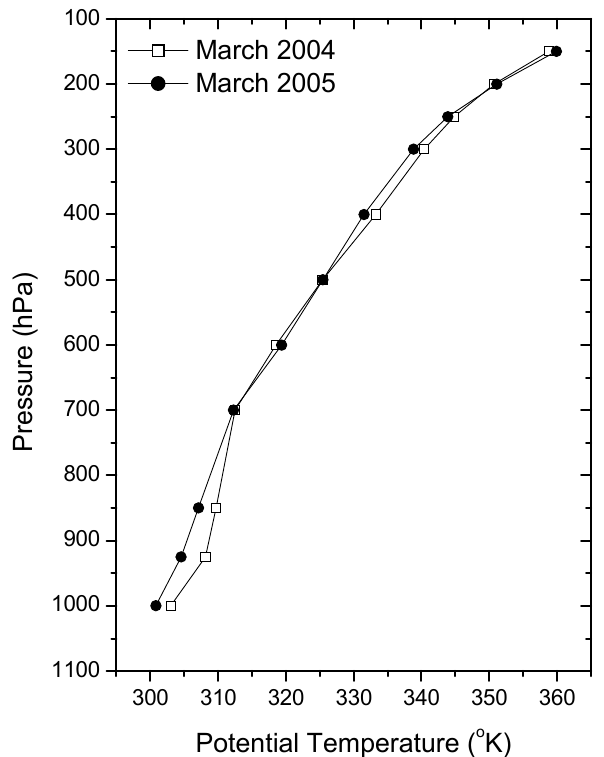
Fig. 10. Monthly mean (for March) altitude profiles of potential temperature for 2004 and